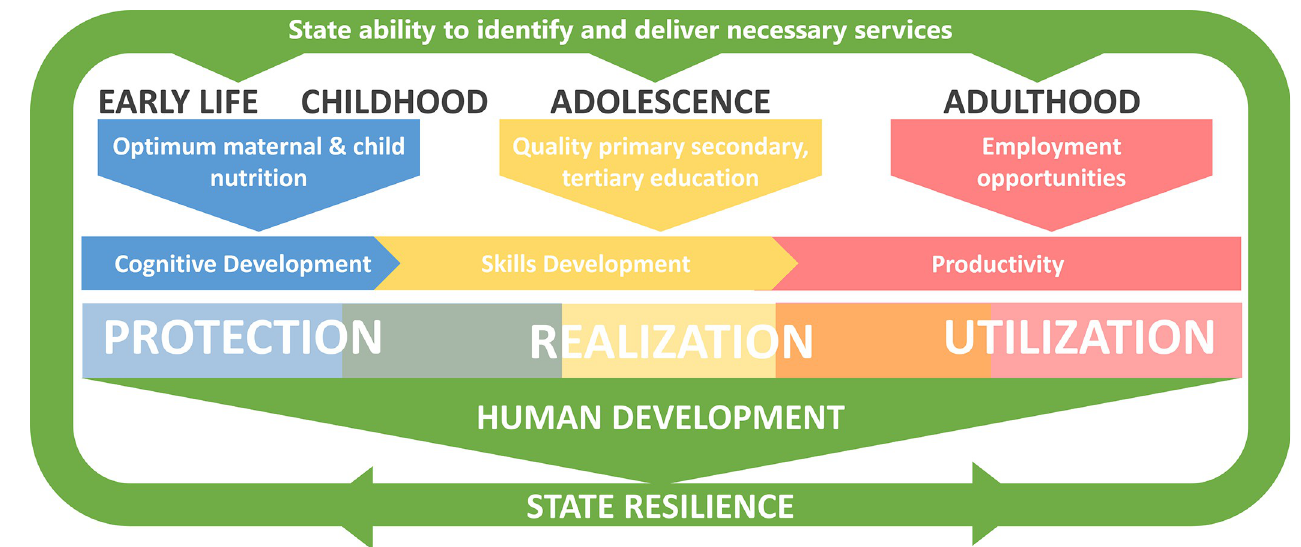
Fig 1. The impact of nutrition interventions through cognitive development, within the human development